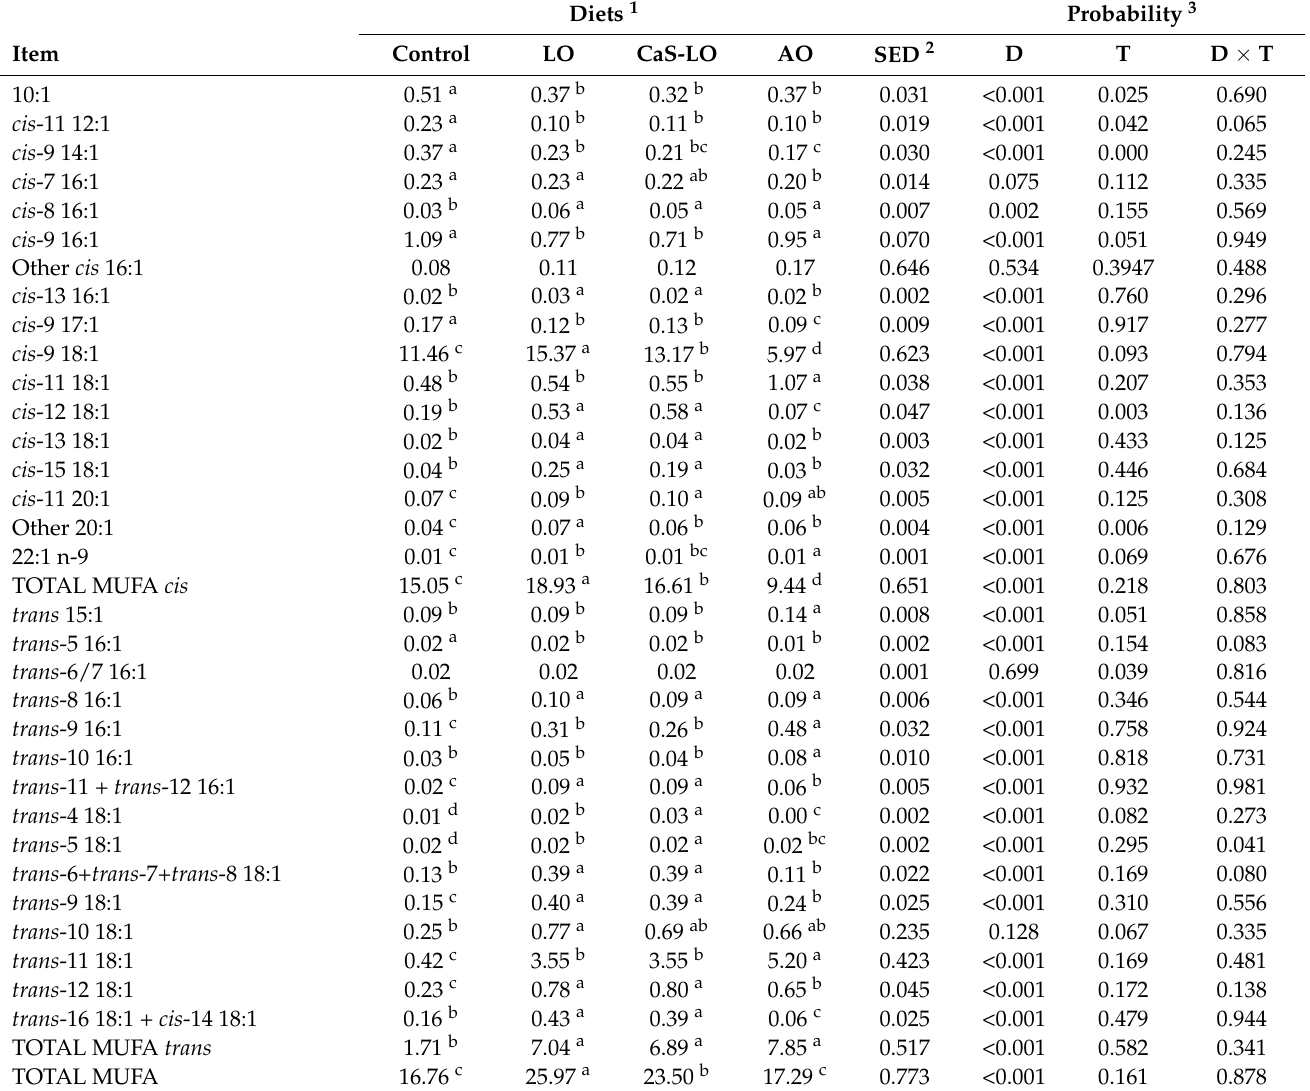
Table 4. Monounsaturated fatty acid (MUFA) profile (g/100 g of total fatty acid methyl esters) of milk fat from ewes fed with 2.3% of different lipid supplements. Diets 1 Probability